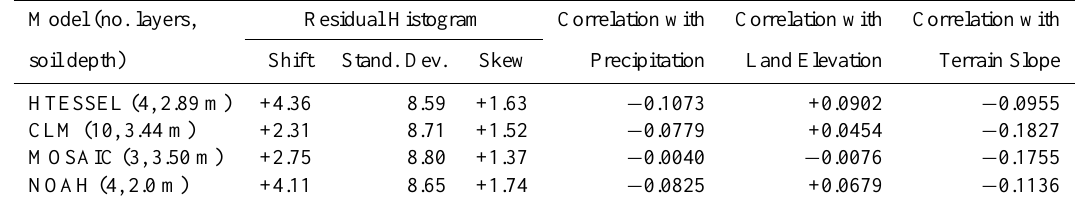
Table 2. Same as Table 1, but over the Amazonian ecosystem (outline in Fig. 1). Model (no. layers,